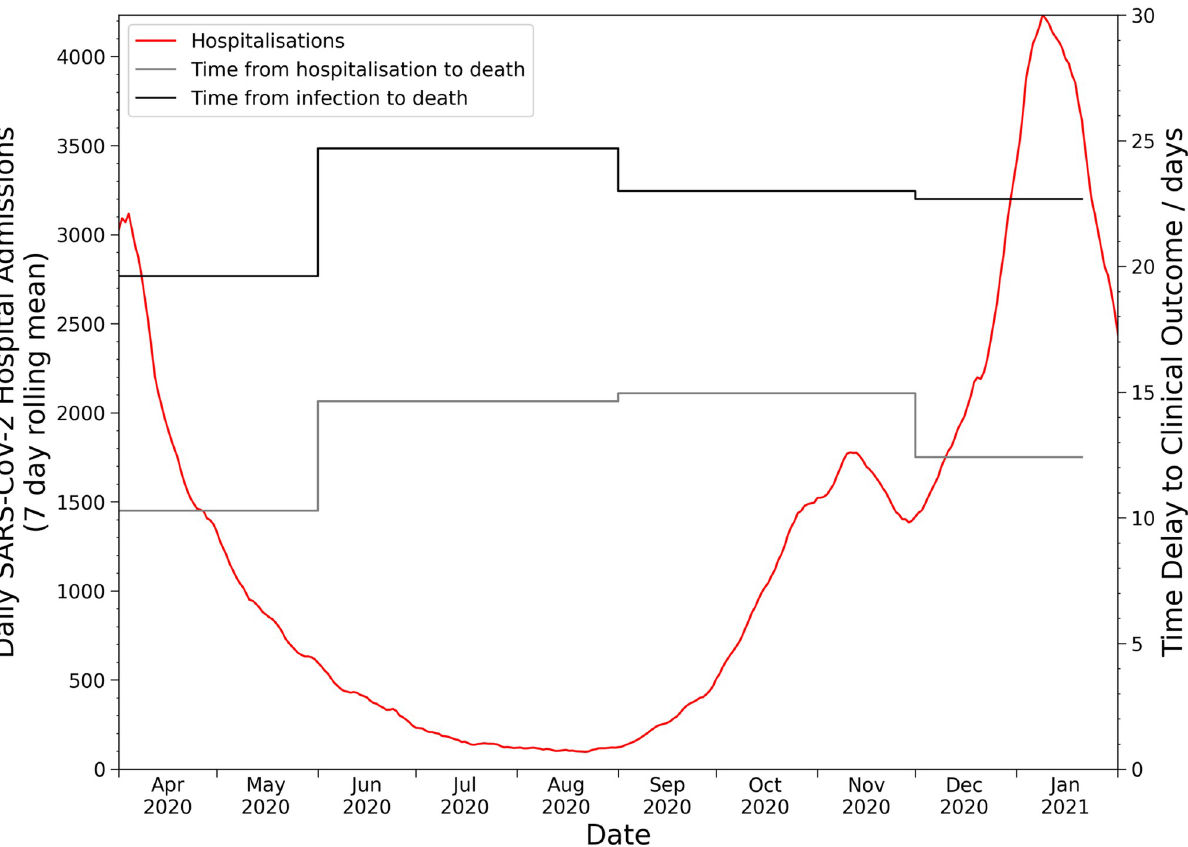
Fig 3. Line graph of the relationship between healthcare pressure, as measured by daily hospital admissions, and the mean modelled clinical time delays.